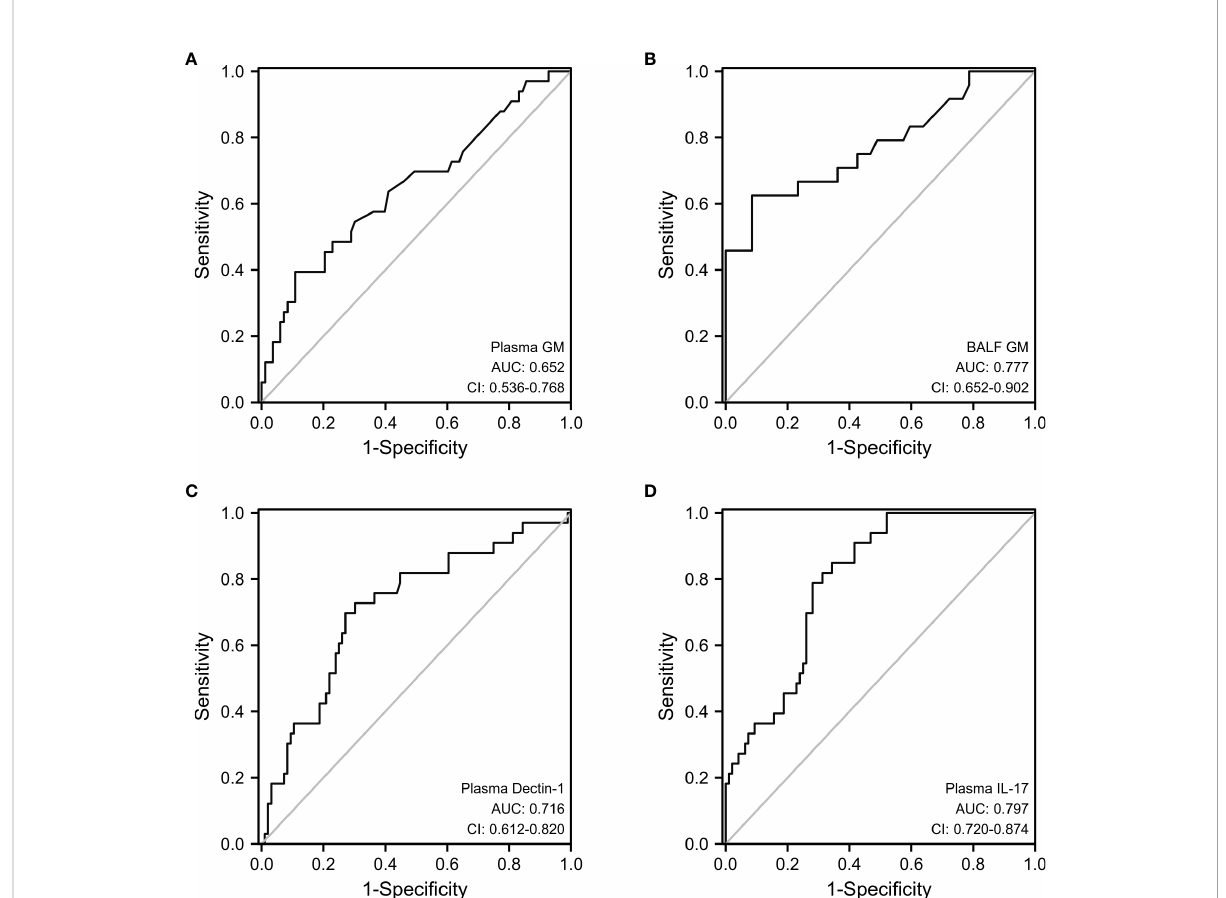
FIGURE 2 ROC analysis of plasma GM (A) , BALF GM (B) , plasma Dectin-1 (C) , and plasma IL-17 (D) to predict patients with bronchiectasis with